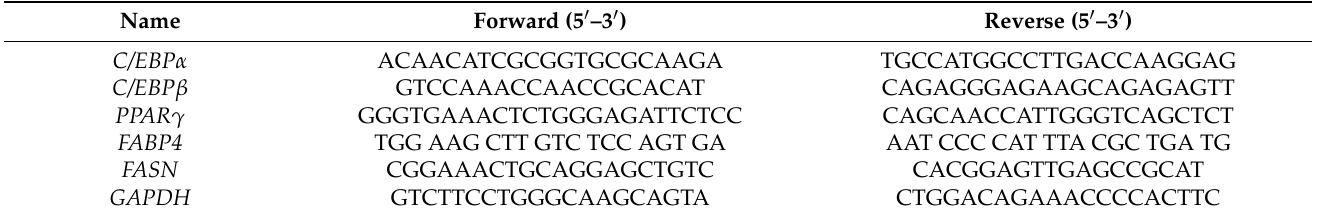
Table 1. List of primers used for real-time